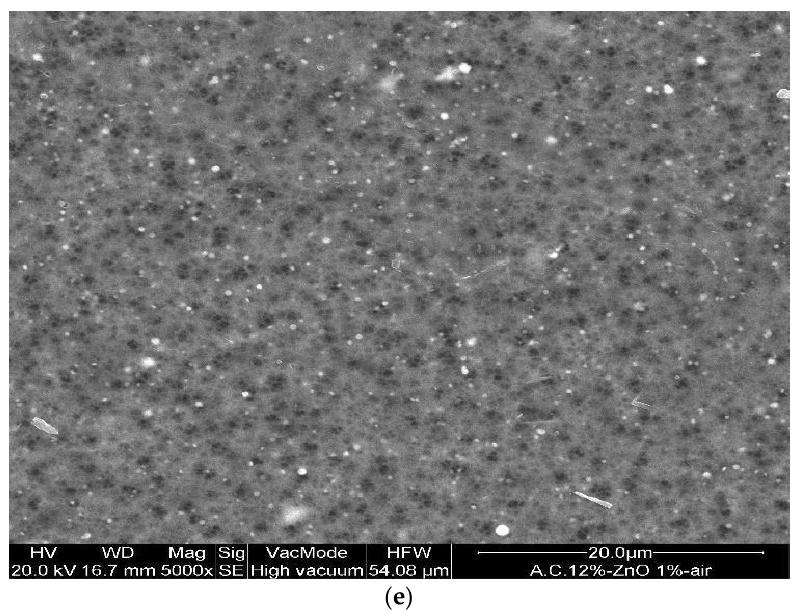
Figure 3. Cross-section of the asymmetric blended membranes: ( a ) CA10%–ZnO1%; ( b ) CA12%–ZnO1%; ( c ) CA15%–ZnO1% (this last image has been acquired in BSE). Top view of the membranes: ( d ) CA12% and ( e ) Ca12%–ZnO1%.